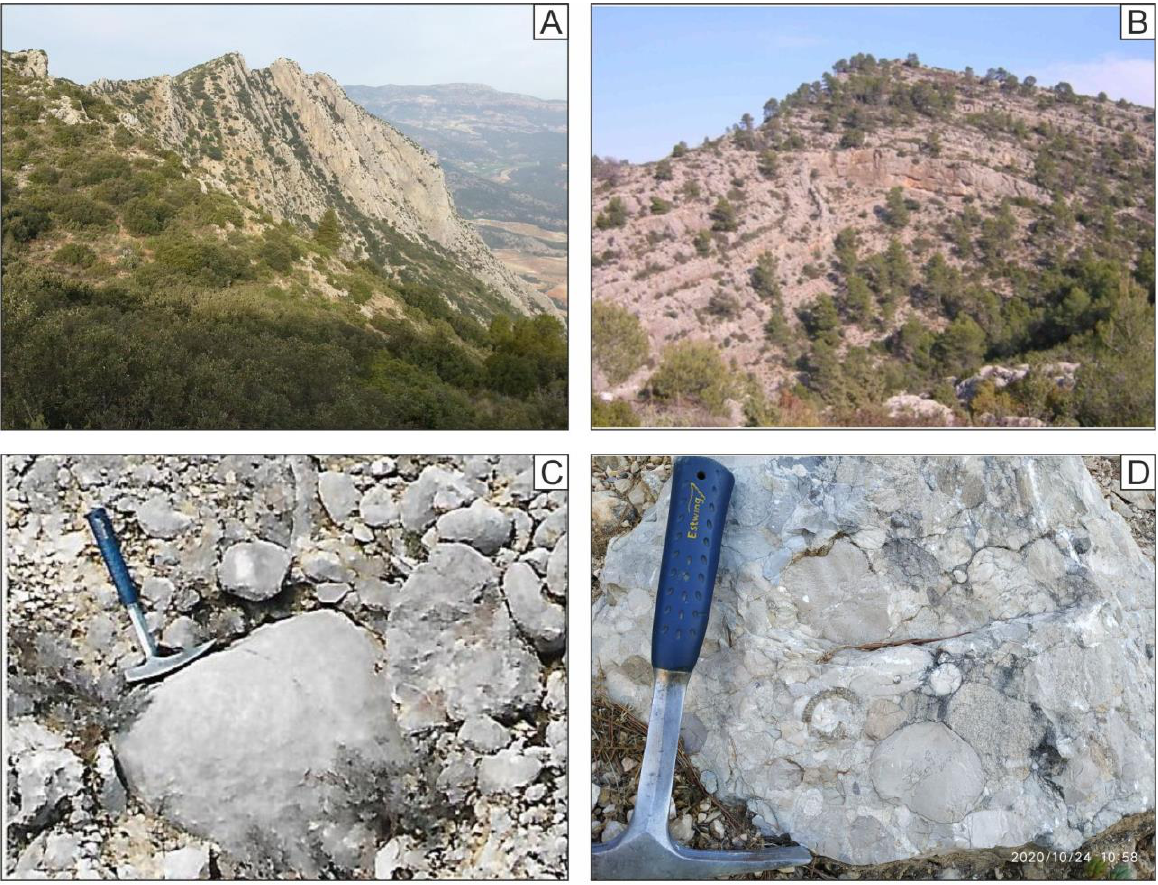
Figure 10. Site 6: The Upper Oligocene-Lower Aquitanian Bosque Fm in the Casas Nuevas area. ( A ) Panoramic view of the Bosque Fm (limestones and calcareous conglomerates). ( B ) Anticlinal fold in the Bosque Fm. ( C ) Detail of the calcareous pebbles. ( D ) Detail of calcareous conglomerates.